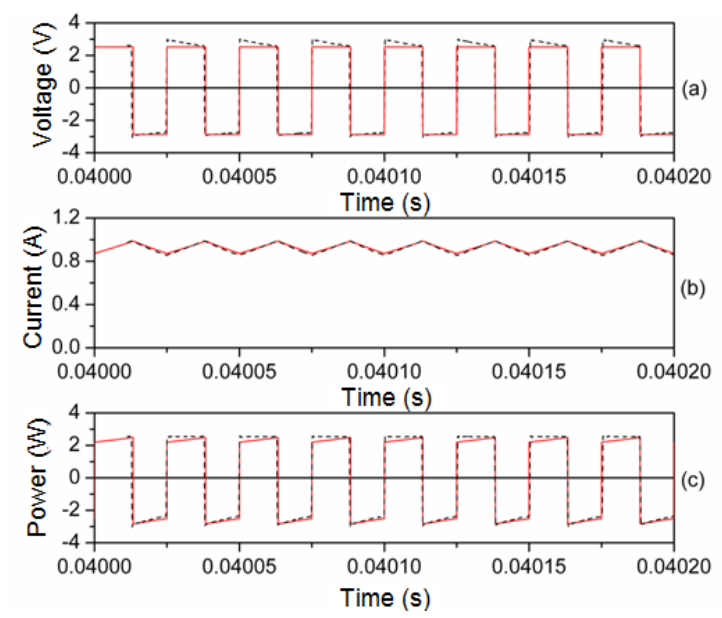
Figure 8. Experimental (-  -  -) and simulated (  ) waveforms at 40 kHz. V time step  = 10 −8 s.